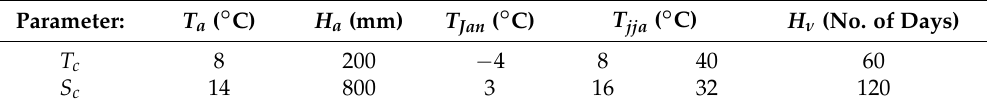
Table 2. The climatic thresholds limiting the establishment of Ae. albopictus